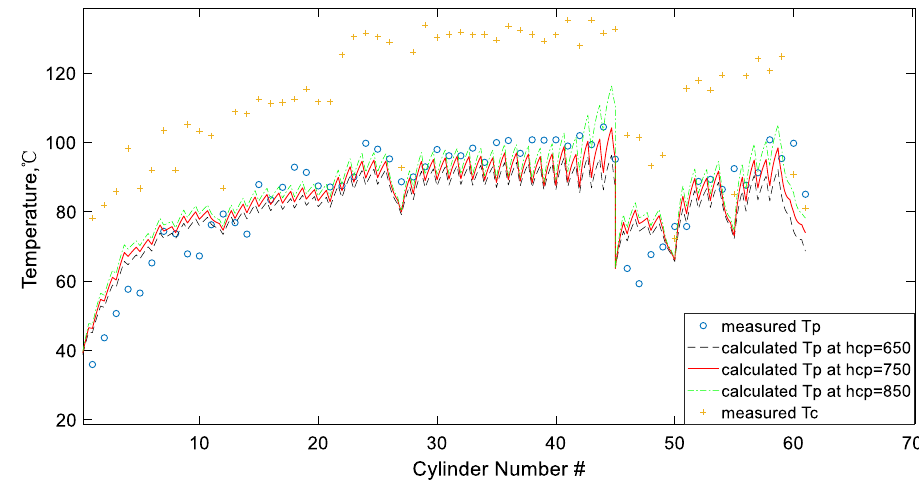
Fig. 3 Comparison between the measured and calculated T p with different h